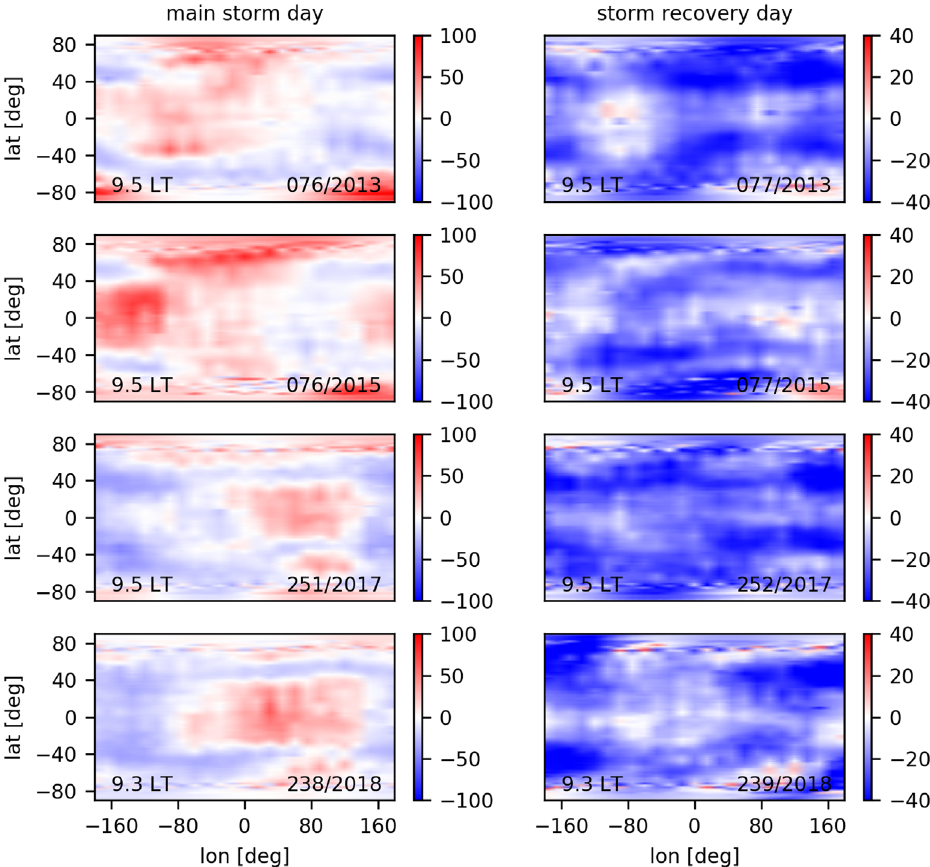
Fig. 6. Percentage of enhancement of the electron density at 800 km during the days of the storm in comparison to quiet days (74/2013, 74/ 2015, 249/2017 and 236/2018). Units of the color bars are given in